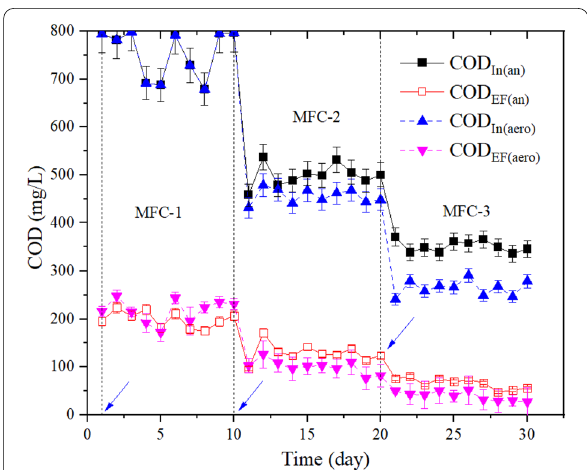
Fig. 5 COD concentration in the influent (COD IN ) and effluent (COD EF ) for aerobic-MFC and anaerobic-MFC integrated system. (an) indicates anaerobic-MFC, and (aero) shows an aerobic-MFC integrated system. The arrows show treatment phase change: wastewater replacement and the systems were allowed to stabilize again. The pre-stabilization period was not shown in the graph. Error bars indicate standard deviation